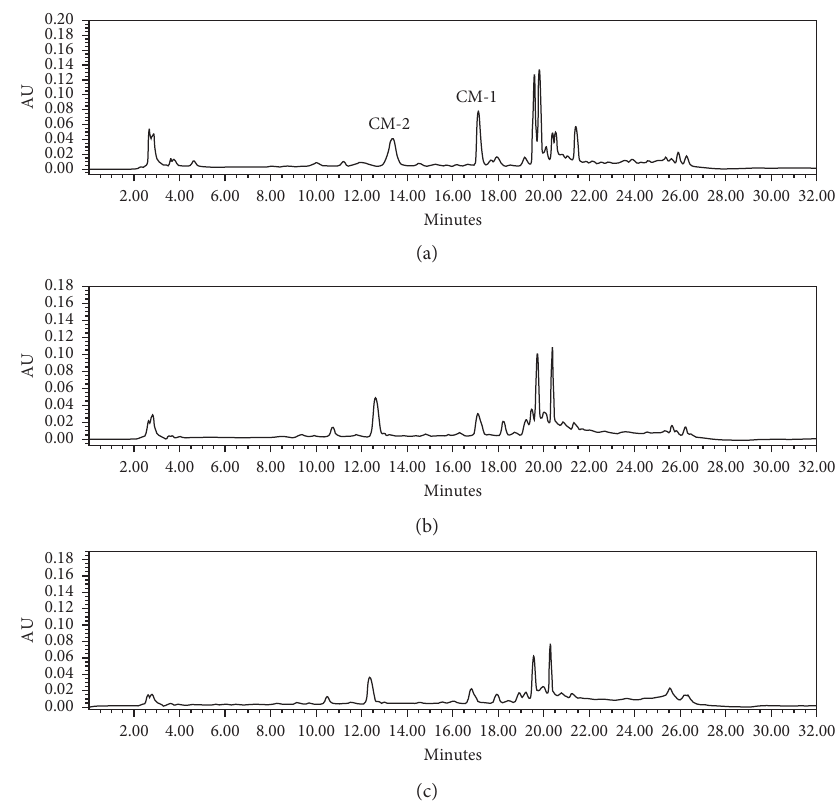
Figure 6: HPLC chromatograms of C. myrrh. (a) MSPD extraction method. (b) Soxhlet extraction method. (c) Sonication extraction method.